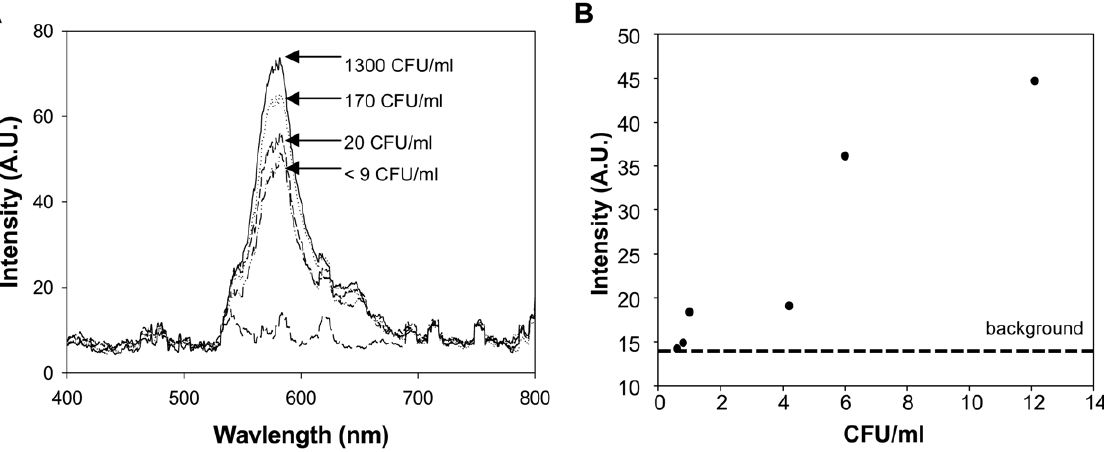
Figure 4. Detection of DNA released from microwave-lysed CVD 1920 (pGEN206) suspended in bacteriological media. Serial dilutions from two independent samples were examined: A) 10-fold serial dilutions of a 10 3 CFU/ml suspension and B) 2-fold serial dilutions of a 12 CFU/ml suspension.